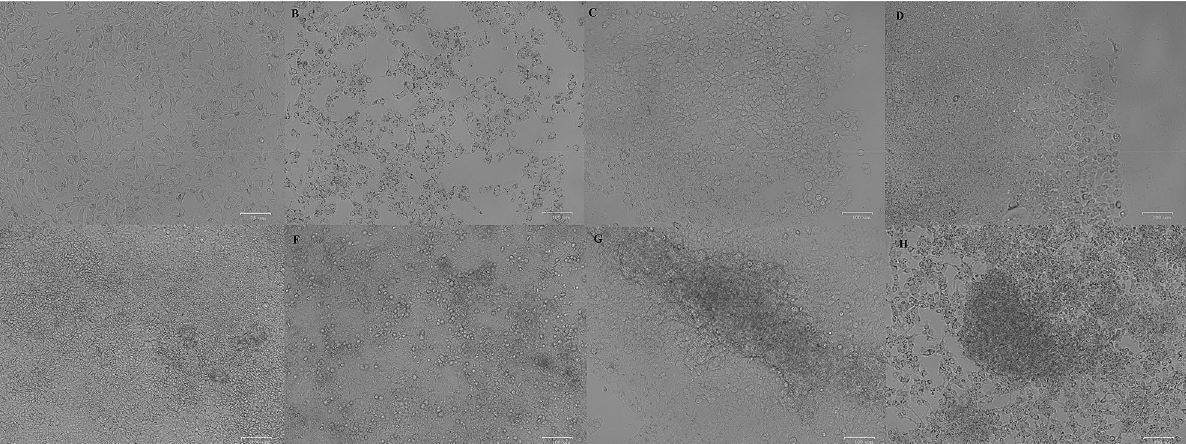
Figure 2. Morphological changes during TAM-R development using two approaches, ( A ) control MCF-7 cells without any tamoxifen treatment. Figures ( B ), ( C ), ( D ) and ( E ) represent MCF-7 cells treated with 30, 40, 45 and 50 μM tamoxifen from the first approach, respectively. MCF-7 cells treated with tamoxifen ( F ) 35 μM two times, ( G ) 35 μM four times and ( H ) 35 μM six times in the second approach. Images were taken using ZOE Fluorescent Cell Imager (Bio-Rad, USA) (Scale bar 100 μm).